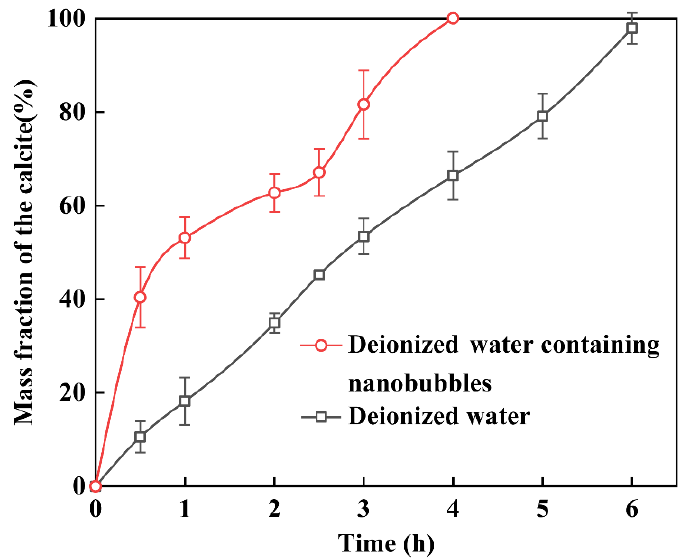
Figure 4. Mass fraction of the calcite (W calcite /W calcite+vaterite ) as a function of the reaction time in deionized water containing nanobubbles and deionized water.